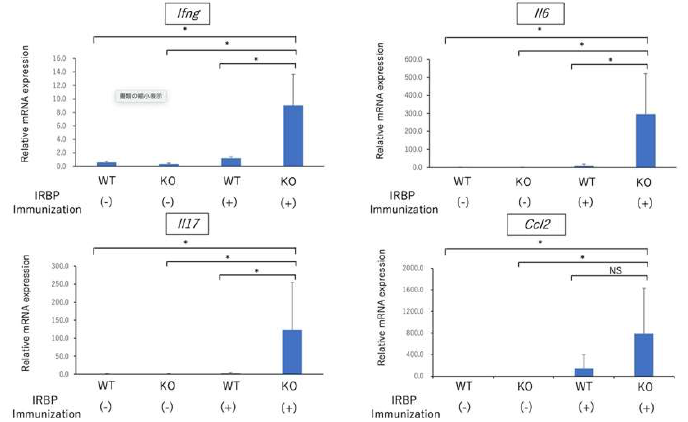
Figure 3. The expression of inflammatory cytokines in retina at early phase of EAU. Wild type (WT) and Nrf2 knockout (Nrf2 KO) mice were immunized with IRBP peptide, and retina was collected from enucleated eyes on day 14 after immunization. Total RNA was extracted from retina of non- immunized WT mice, non-immunized Nrf2KO mice, WT mice immunized with IRBP peptide and Nrf2KO mice immunized with IRBP peptide. The quantitative PCR was performed regarding the gene expression of Ifng, Il17, Il6, and Ccl2 (MCP-1). The mean ± standard deviation for each group ( n = 4–5 mice per group) is shown. Asterisk indicates p < 0.05 versus WT mice. Statistical analysis was performed according to ANOVA followed by Bonferroni test. NS: not significant. As described earlier, rodent EAU is mediated by Th1 and Th17 immune response